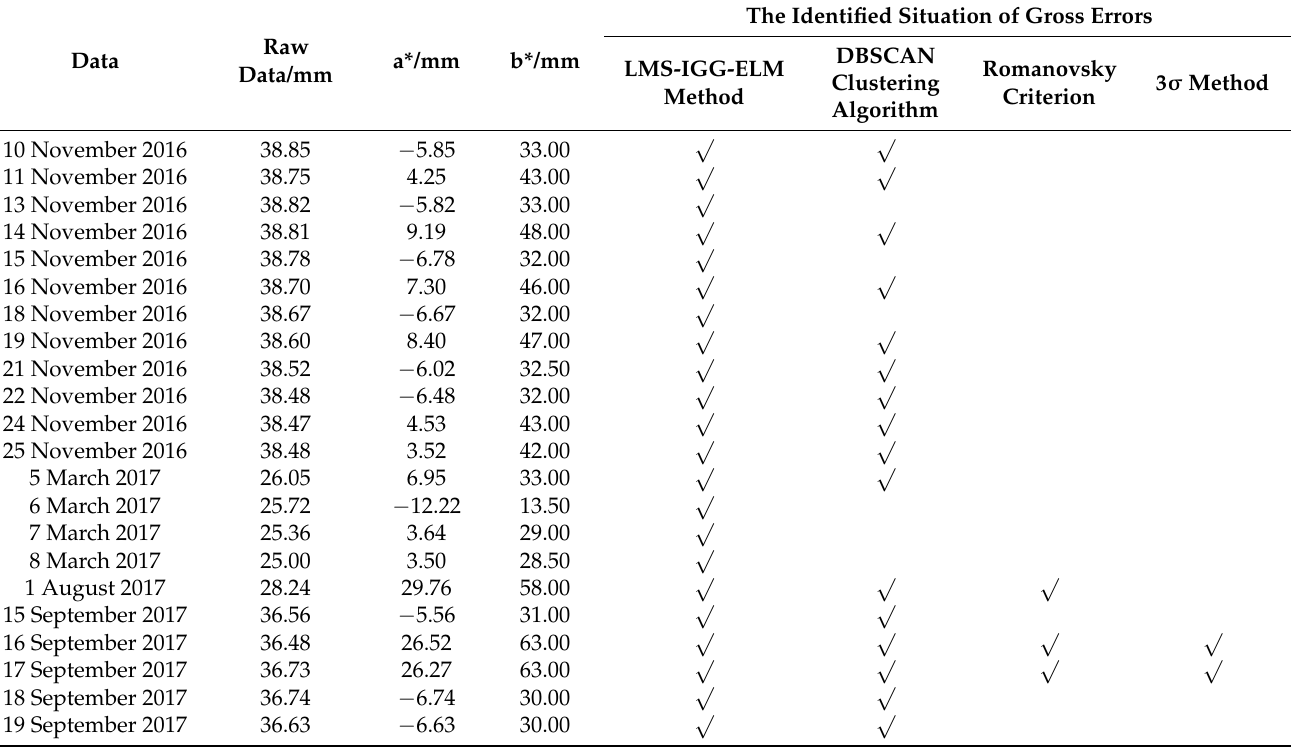
Table 4. Gross errors insertion positions and gross errors identification under the four methods.